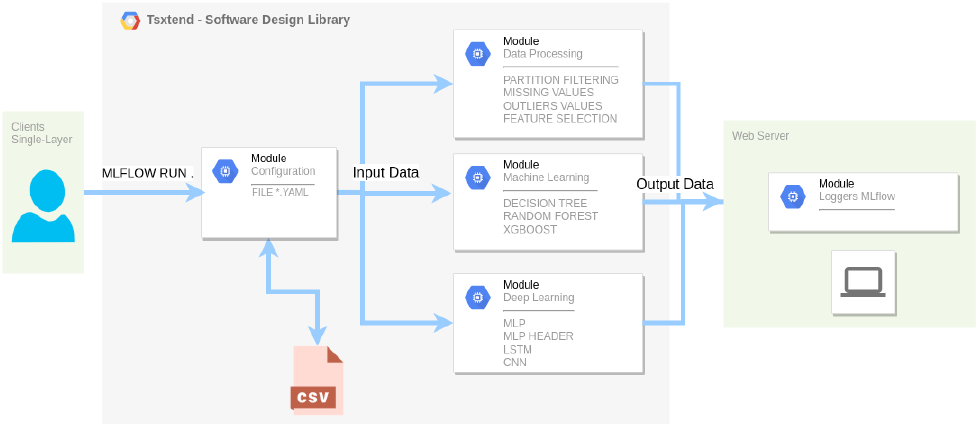
Figure 1. Design of the proposed